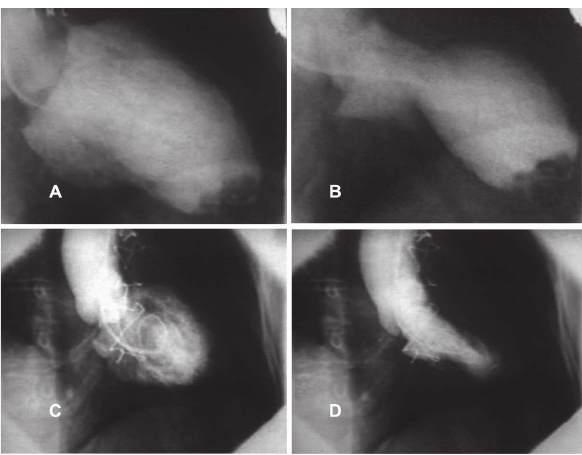
Fig. 3 - (A) Pre-operative oblique anterior angiogram with left ventricle during diastole showing an enlarged cavity. (B) Pre- operative oblique anterior angiogram with left ventricle during systole showing an enlarged cavity and dyskinetic anterior wall. (C) Post-operative oblique anterior angiogram with left ventricle during diastole with a normal left ventricle volume. (D) Post- operative oblique anterior angiogram with left ventricle during systole with normal volume and shape